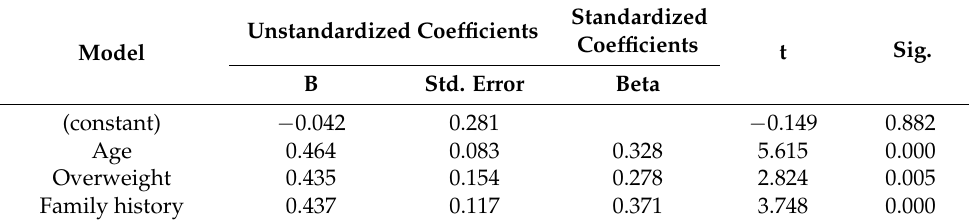
Table 12. Multilinear Regression results of female samples/ANOVA a . Mean Sum of F Sig. df Model Square Squares Regression 91.068 3 30.356 45.244 0.000 b Residual 110.707 165 0.671 Total 201.775 168